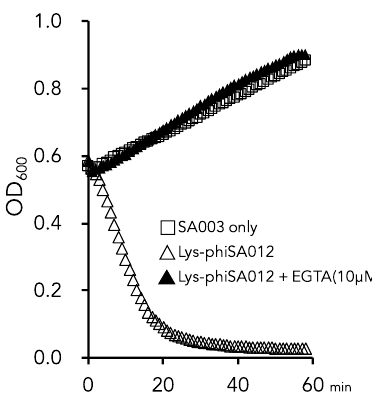
Figure A2. The effect of EGTA treatment on Lys-phiSA012 lytic activity. The lytic activity of Lys-phiSA012 w/wo EGTA was determined using the turbidity reduction assay. SA003 was grown in LB medium w/wo 10 mM EGTA and the assays were initiated by the addition of 64 µg/mL Lys-phiSA012.